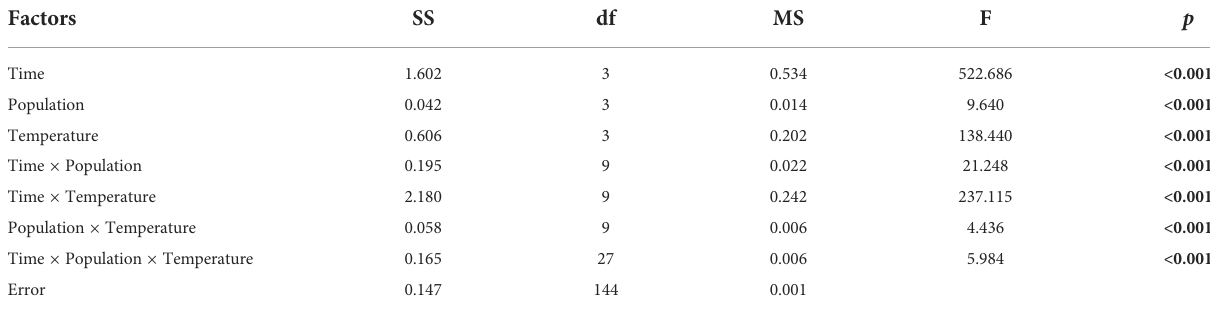
TABLE 3 Three-way repeated measures ANOVA for the effects of population, temperature, and time on the maximum quantum yield of photosystem II (F v /F m ) of Laminaria ochroleuca gametophytes.